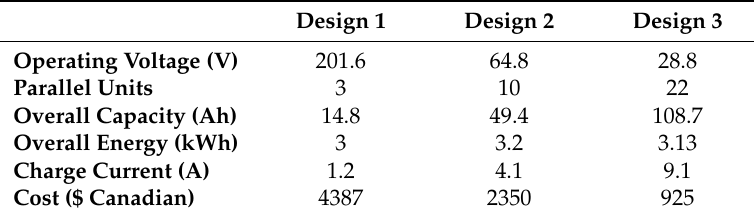
Table 6. Proposed battery pack design summary.